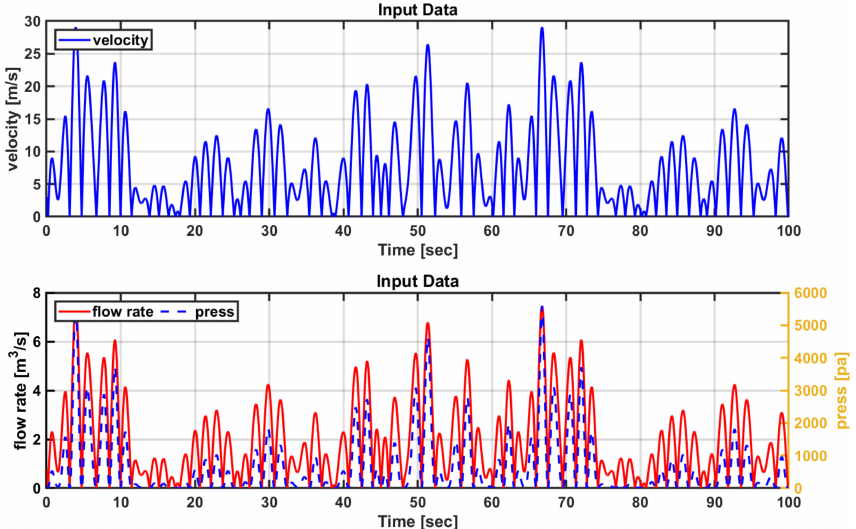
Figure 21. Water level in the OWC chamber, turbine flow velocity, turbine flow rate, and pressure in the condition of input irregular wave ( v t = 0~30 m / s and Tp = 4.75